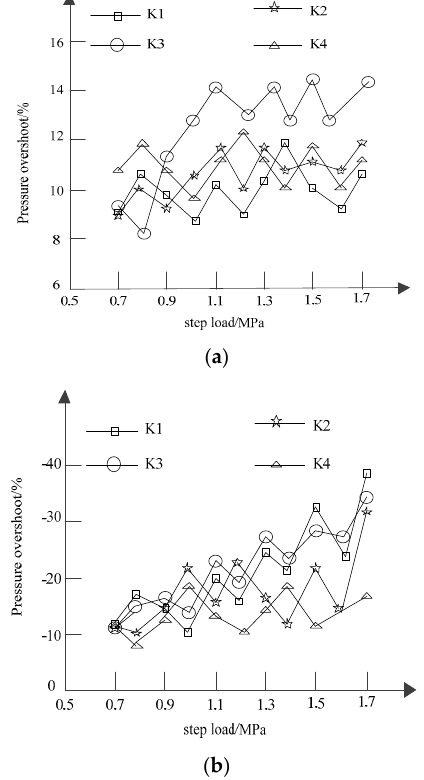
Figure 6. Dynamic changes in hydraulic-valve pressure. ( a ) Loading of step load; ( b ) unloading of step load.